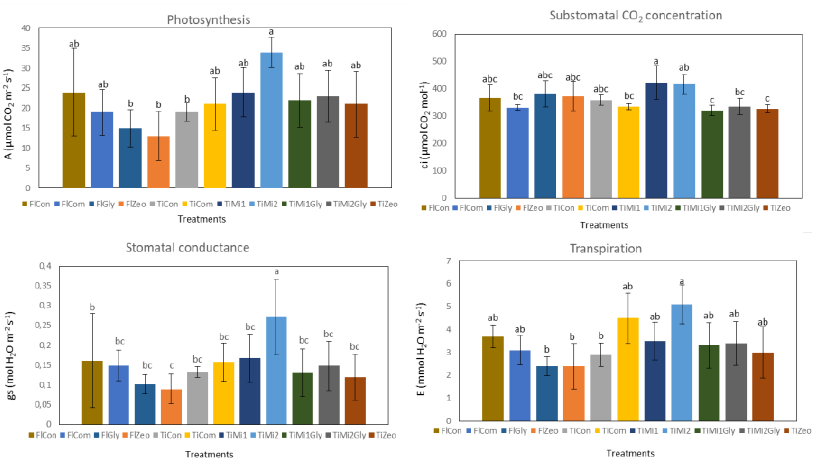
Figure 3. Apical leaf gas exchanges detected on July, 50 DAMB, third year, in the morning between 8:30 and 11:00 a.m. Data are the mean of 4 replicates. The letters on the columns show significant differences between the treatments according to ANOVA, least significant difference (LSD) analyses at p -value threshold ≤ 0.05. Error bars represent standard deviation. FlCon: flat soil, without any addition; FlCom: flat soil, with addition of compost (130 t ha − 1 ); FlGly: flat soil, with addition of glycine-betaine; FlZeo: flat soil, with addition of zeolite; TiCon: soil tilled to form raised ridges of about 50 cm in rows, without any addition; TiCom: soil tilled to form raised ridges of about 50 cm in rows, with addition of compost (80 t ha − 1 ); TiMi1: soil tilled to form raised ridges of about 50 cm in rows, with addition of microbial consortium 1; TiMi2: soil tilled to form raised ridges of about 50 cm in rows, with addition of a microbial consortium 2; TiMi1Gly: soil tilled to form raised ridges of about 50 cm in rows, with addition of a microbial consortium 1 and addition of glycine-betaine; TiMi2Gly: soil tilled to form raised ridges of about 50 cm in rows, with addition of a microbial consortium 2 and addition of glycine-betaine; TiZeo: soil tilled to form raised ridges of about 50 cm in rows, with addition of